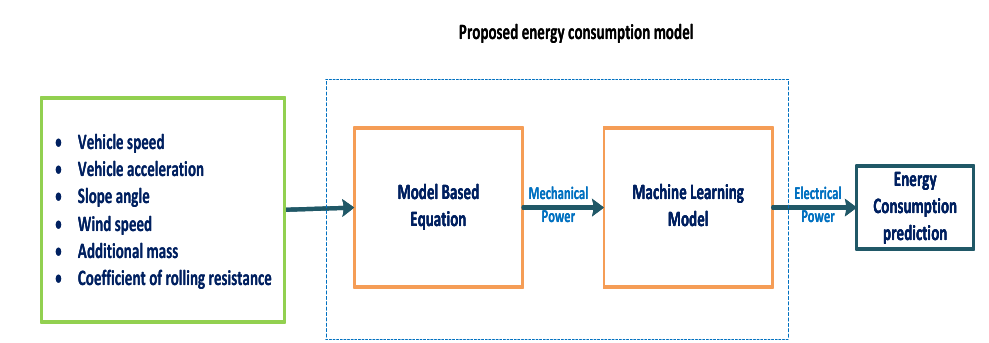
Figure 6. Schematic overview of the proposed energy consumption prediction model.